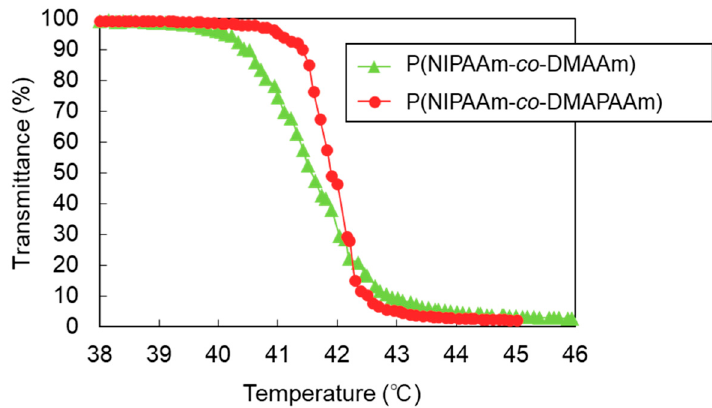
Figure 2. Phase transition behavior of the thermoresponsive polymers in phosphate buffer saline (PBS). The lower critical solution temperature (LCST) was defined as the temperature at which the optical transmittance of the polymer solution was 50% of the difference between the maximum and minimum transmittances.